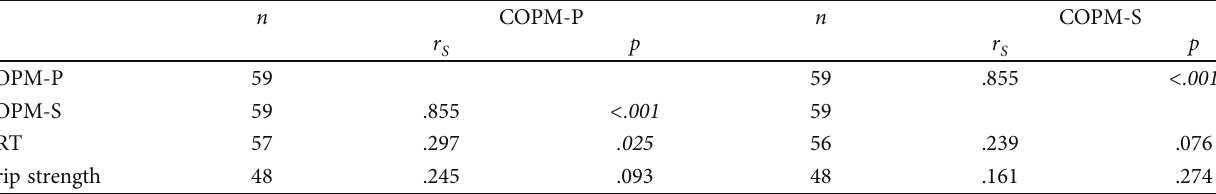
Table 4: Association between change in Canadian Occupational Performance Measure (COPM) scores and Grasp and Release Test (GRT) and between change in COPM scores and grip strength (JAMAR) from baseline to the 12-month